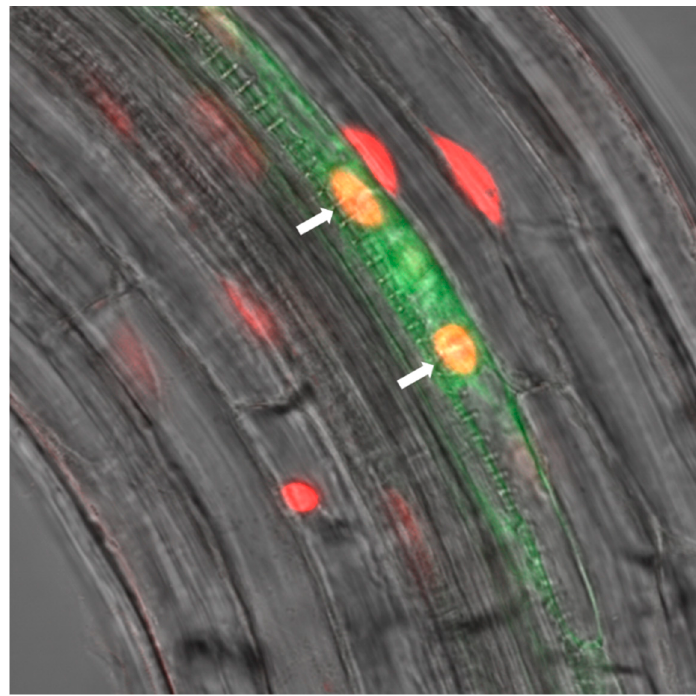
Figure 2. The RBR1 protein is present in lateral root (LR) founder cells in the pericycle. Laser scanning microscope image of J0192:: pRBR:RBR-RED FLOURESCENT PROTEIN (RFP) root showing RBR-RFP fluorescence (red) and pLBD16::GREEN FLOURESCENT PROTEIN (GFP) fluorescence (green) marking lateral root founder cells in the pericycle. White arrows mark the position of the LR founder cells.